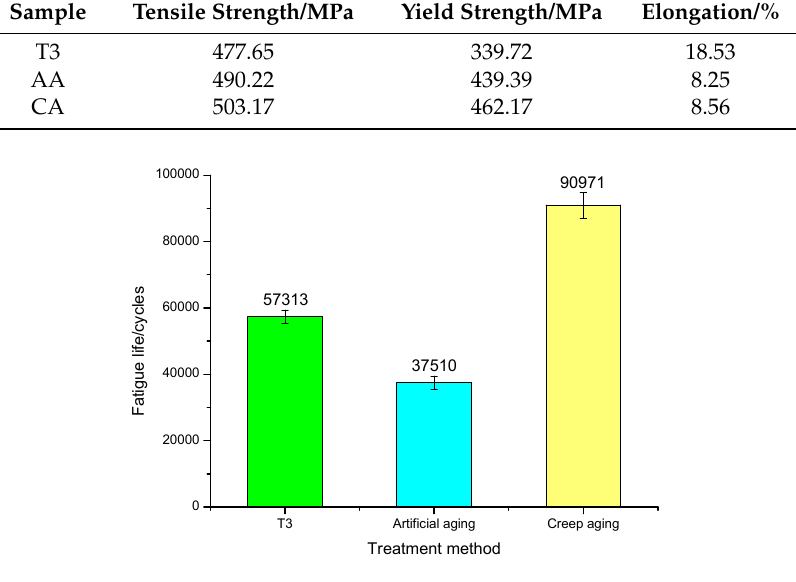
Figure 1. Fatigue lives of samples.